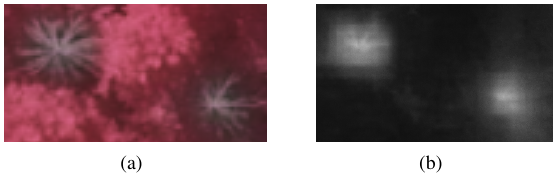
Figure 7. Loss of detail due to transformation into probability image.